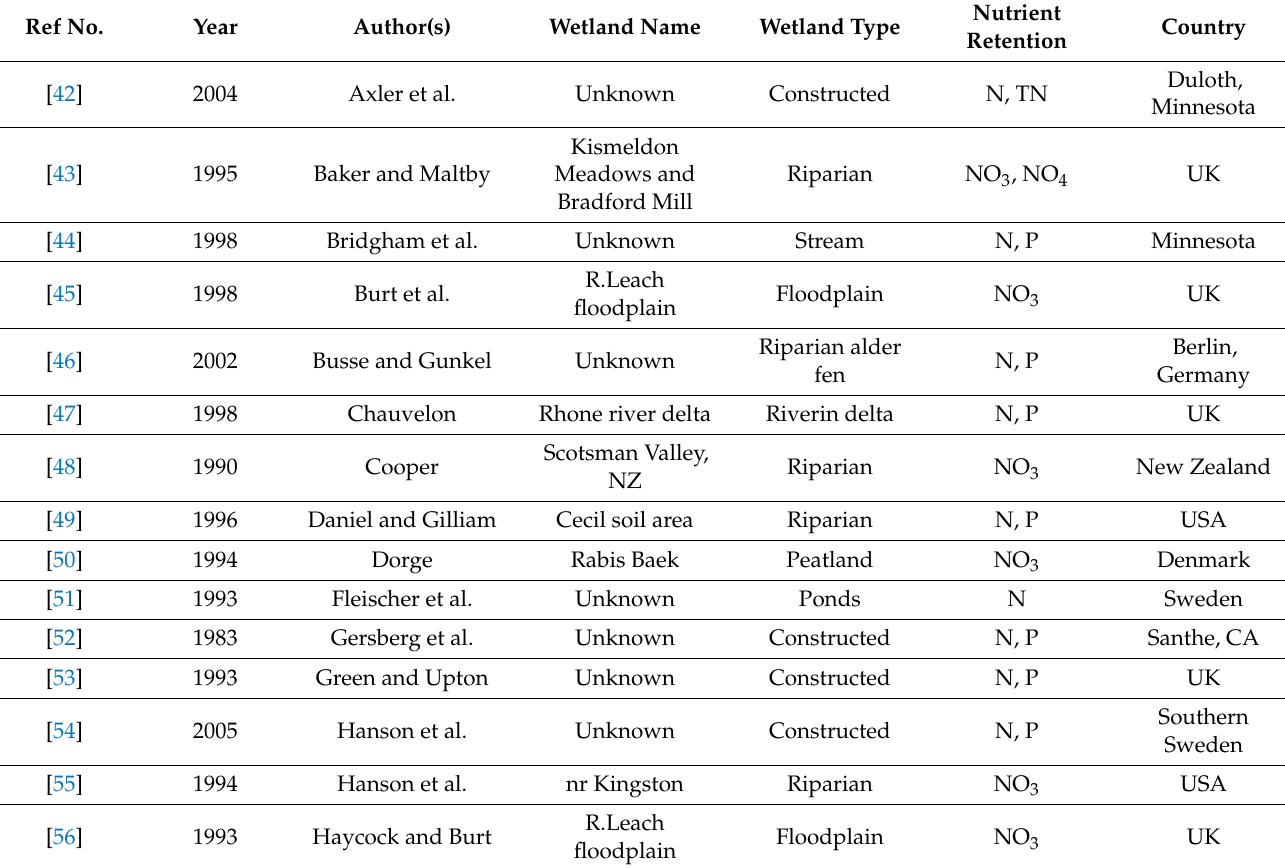
Table 1. List of references recording nutrient retention in wetlands. N = several N species, NO 2 = nitrite, NO 3 = nitrate, NH 4 = ammonium, P = several P species, TN = total or Kjeldahl nitrogen, TP = total phosphorous, and TPN = total particulate nitrogen. Ref